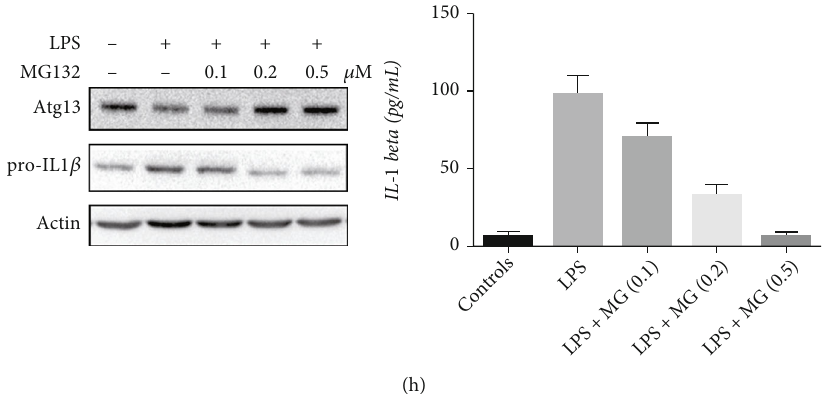
Figure 8: LPS induces Atg13 loss via proteasome-dependent degradation. (a) MG132 (0.5 μ M, 8h) increased expression of Atg13, while Baf A1 (200nM, 8 h) did not a ff ect expression of Atg13 in LX2 cells. (b) HEK 293 cells expressing vector or GST-Atg13 and Myc-ubiquitin were treated with MG132 (0.5 μ M, 8 h) as indicated. Cell lysates were subject to Myc-tag or GST-tag a ffi nity isolation and immunoblotted for Atg13 and ubiquitin expression. (c) LX2 cells expressing GST-Atg13 or not were treated with CHX (0-1mg/mL, 2 h). (d) LX2 cells expressing GST-Atg13 were treated with LPS, MG132, or Anisomycin. (e) LX2 cells were treated with LPS, MG132, or Anisomycin as indicated; (f) LX2 cells expressing GST-Atg13 were treated with MG132; expression of ULK1, FIP200, and Atg5 was detected. (g, h) LX2 cells were treated with LPS, CHX, or MG132 as indicated; expression of pro-IL1 β and secretion of IL-1 β were